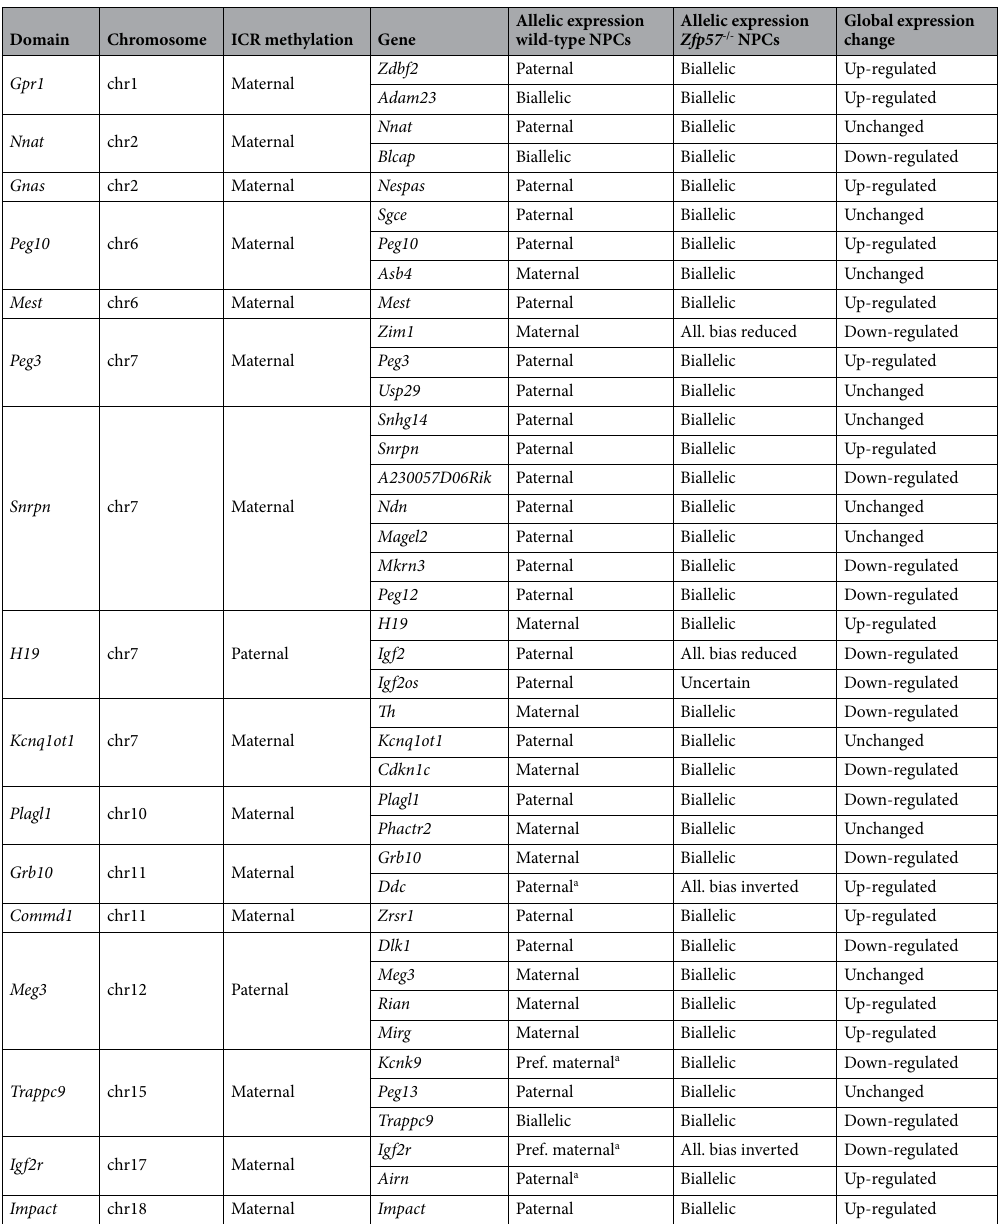
Table 2. Integration of global gene expression with allele-specific expression of imprinted genes in Zfp57 -/- day 12-JB1 cells. a Not statistically